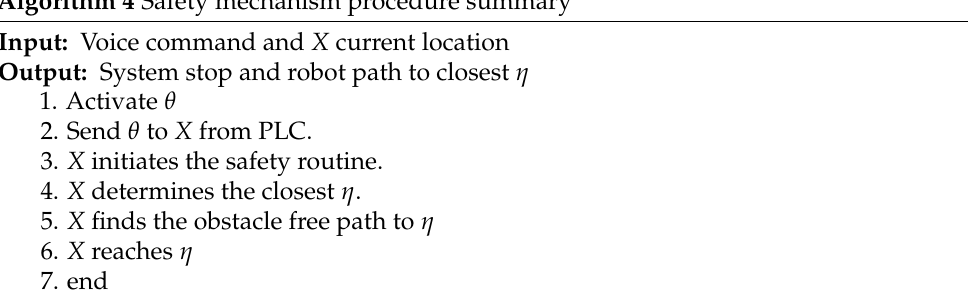
Algorithm 4 Safety mechanism procedure